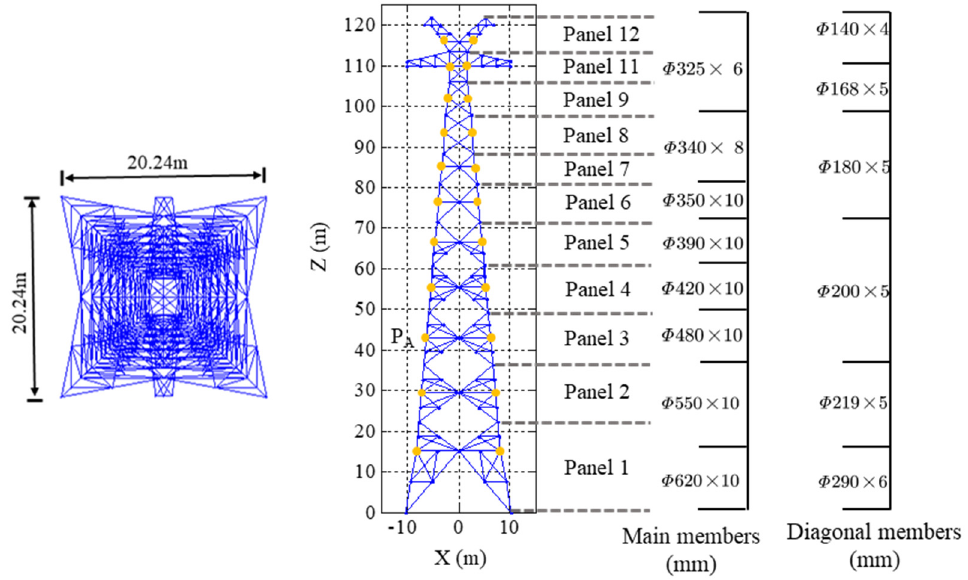
Figure 5. Top and front views of Tower 2.